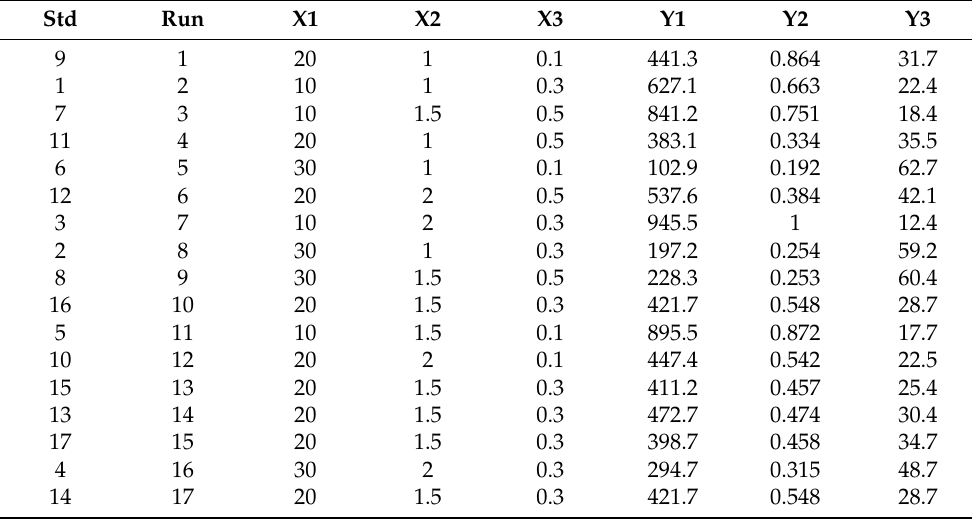
Table 2. BBB designs factors and Observed responses for PAX-RESV